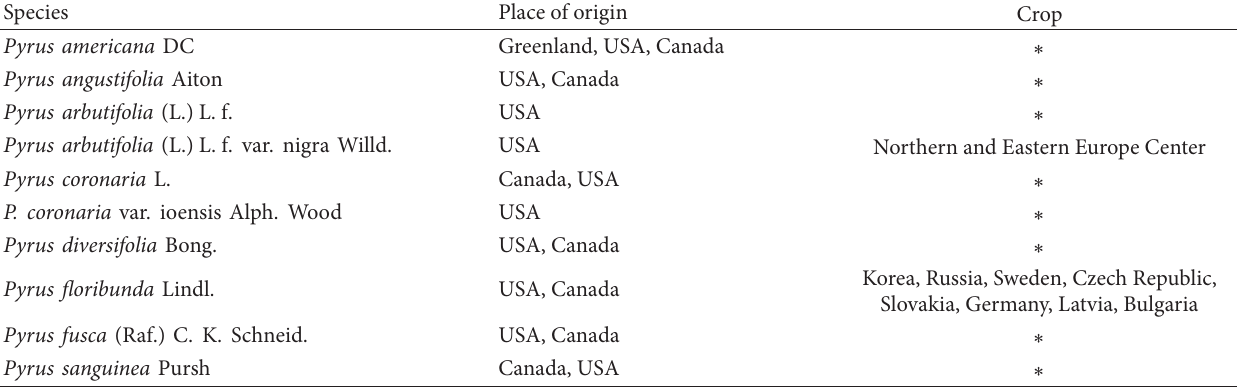
Table 3: Pyrus species and hybrids originating in the Americas.